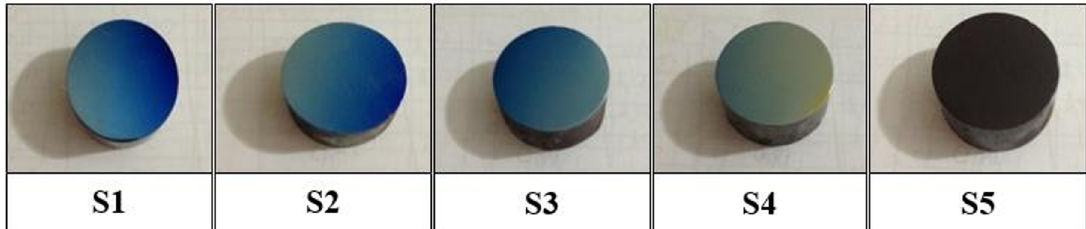
thin films deposited at different oxygen flow rates. Figure 1. Images of TiO 2